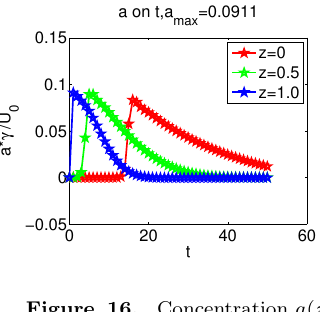
Figure 15. Concentration u ( z,t ) depending on t for u 0 = 0 , ˜ p = 10 ,z = 0;0 . 5;1